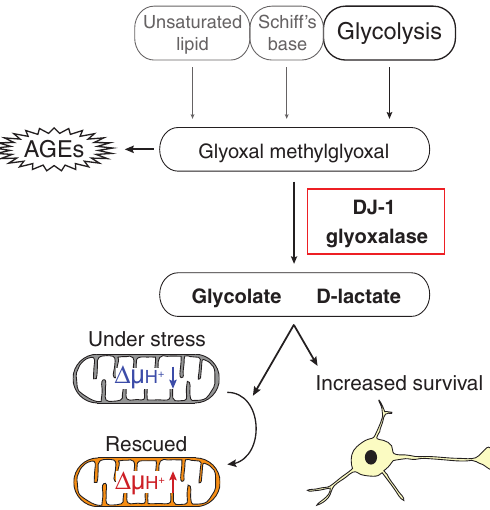
Figure 2: Novel role of glycolic acid and D-lactic acid produced by the DJ-1